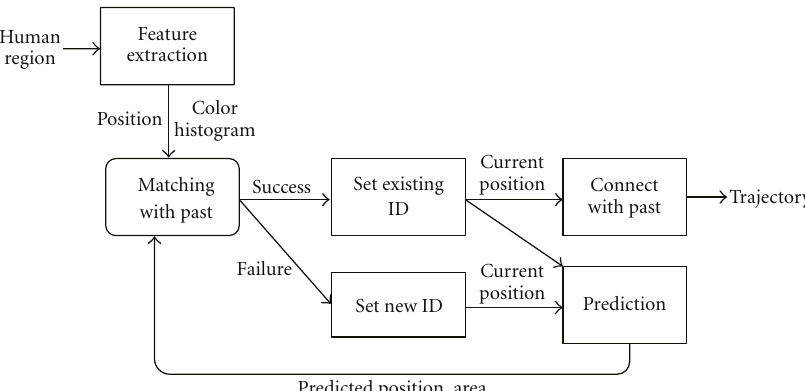
Figure 11: Flow for human region tracking.